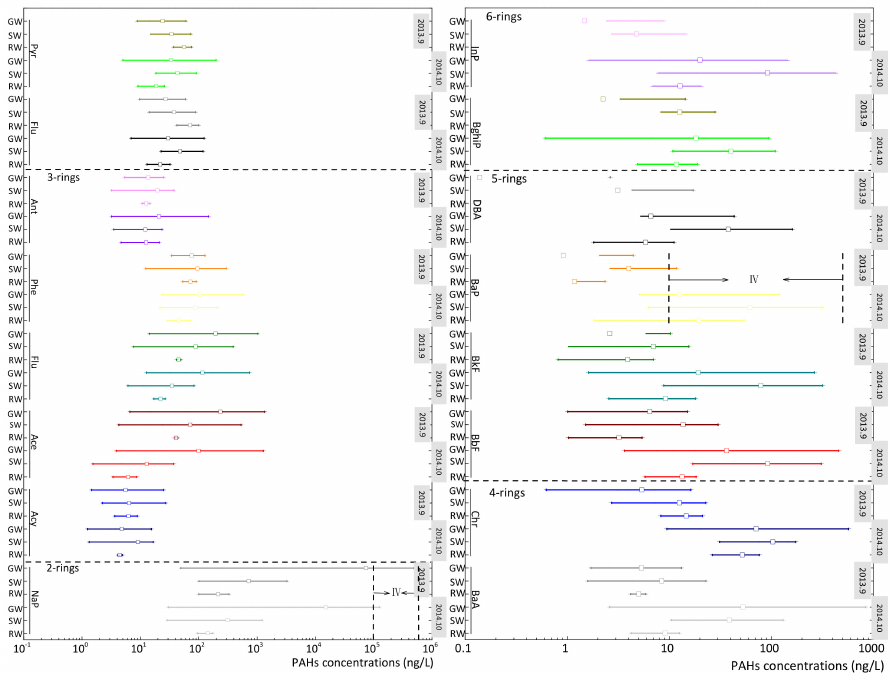
Figure 5. PAHs concentration ranges and mean value in reclaimed water (RW), surface water (SW) and groundwater (GW) as dissolved phase in September 2013 and October 2014.